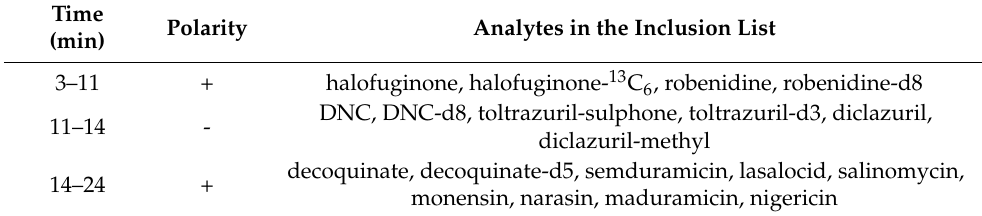
Table 3. PRM acquisition experiments.